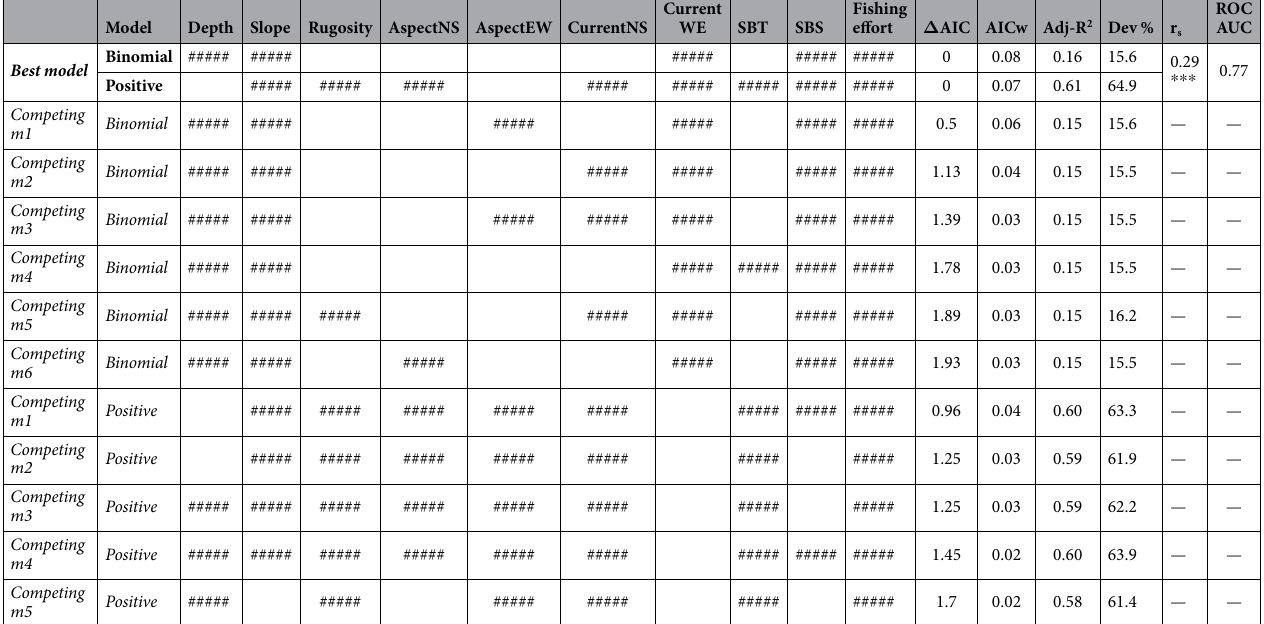
Table 3. Best supported and competing models (using binomial and positive models) for Funiculina quadrangularis . Variables included in model are indicated with the symbol #. Predictors include depth, slope, rugosity, aspectNS, aspectEW, CurrentNS, CurrentWE, sea bottom temperature (SBT), sea bottom salinity (SBS) and fishing effort. Δ AIC: delta AIC (difference in AIC between the best model and current model); AICw: Akaike’s Information Criteria (corrected) weights, values range from 0 to 1, and high values indicate strong support for a given predictor. Models were evaluated by R 2 -adjusted coefficient and deviance (Dev): percentage of deviance explained. Only for the binomial model the Receiver Operating Characteristic (ROC) and Area Under the Curve (AUC) were calculated. Significance value of the Spearman’s correlation coefficient (rs) (corrected for spatial autocorrelation) for the delta model is given as *** p value < 0.001, ** p value < 0.01, * p value <